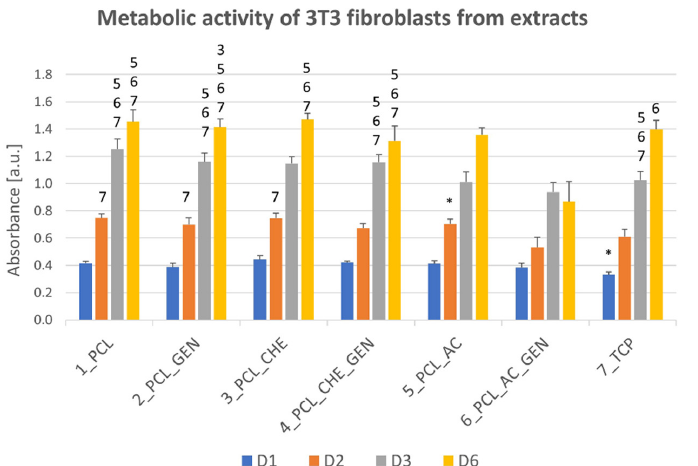
Figure 9. Biocompatibility of extracts of pure nanofiber substrates prepared with different solvents (PCL, PCL_CHE, PCL_AC) and extracts of nanofiber substrates functionalized with solid lipid particles with gentamicin (GEN), tested with murine 3T3 fibroblasts on days 1, 2, 3, and 6. Statistical significance between the groups was set at p ˂ 0.05 and is described in the above columns. * shows the statistical difference compared to all other samples, a number represents the number of the sam- ple.